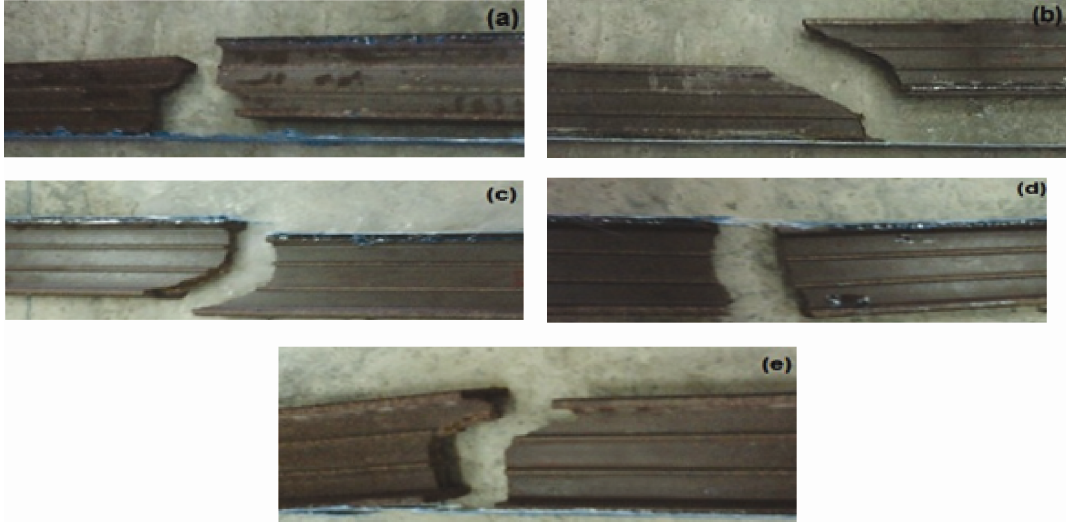
Fig. 6. Failure mode of the specimen beams strengthened in different groups: (a) without any surface preparation; (b) with surface preparation; (c) transverse grooves; (d) diagonal grooves; (e) longitudinal